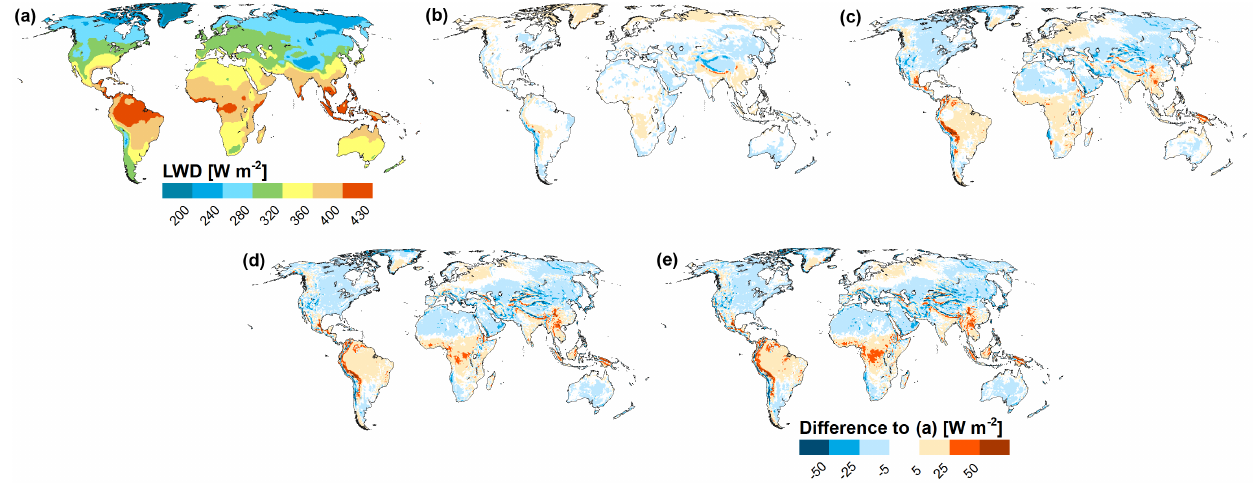
Figure A4. Long-term (1971–2000) average longwave downward radiation of the model variants, displayed as absolute number for GSWP3 (a) and differences to the other forcings, computed as PGFv2 minus GSWP3 (b) , WFD minus GSWP3 (c) , WFD_WFDEI